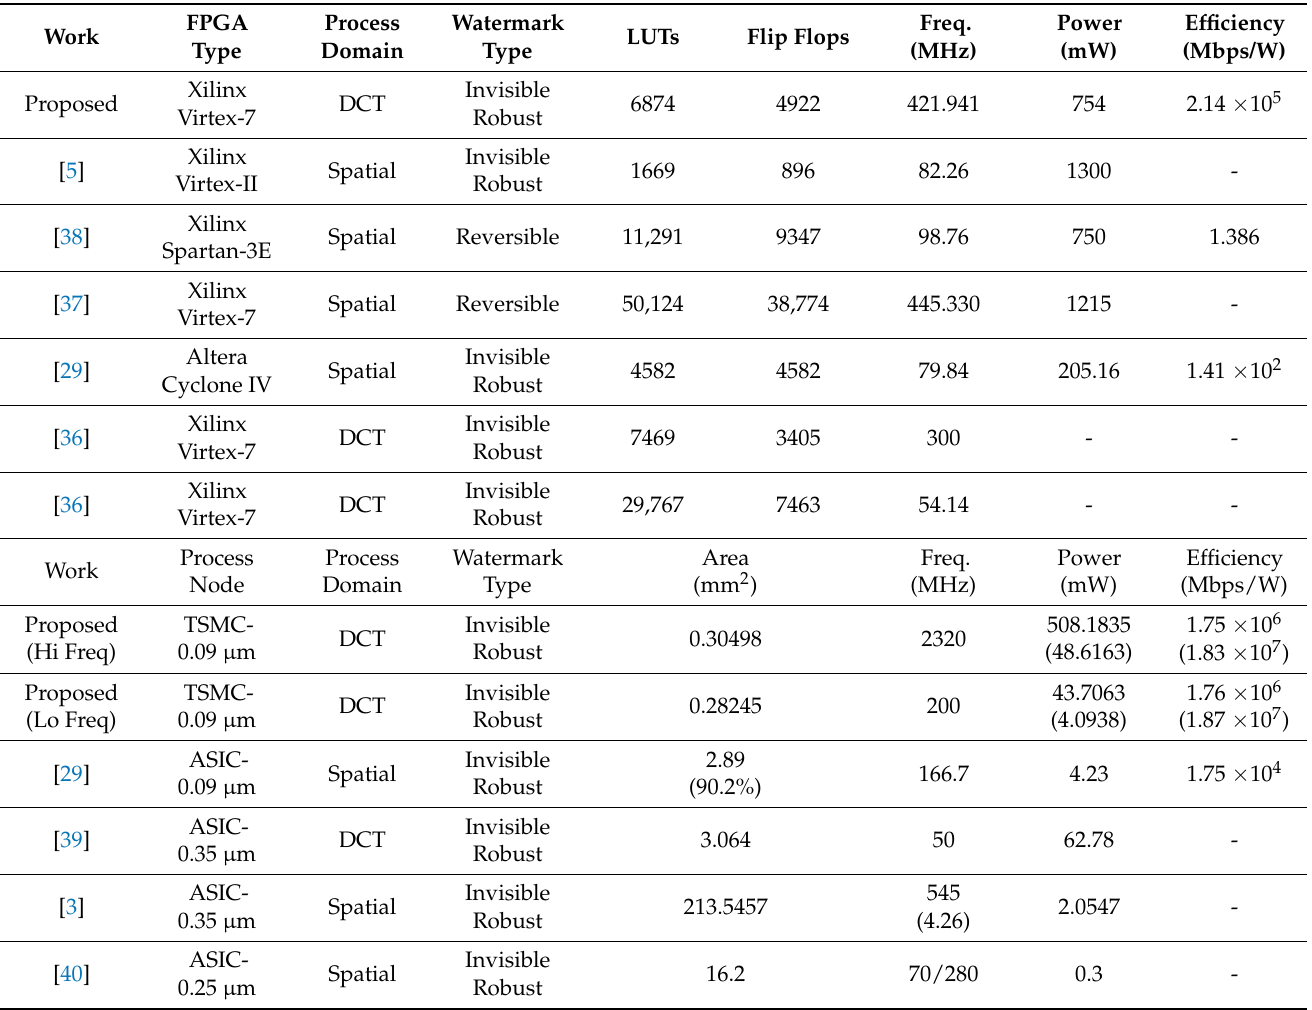
Table 6. Hardware implementation